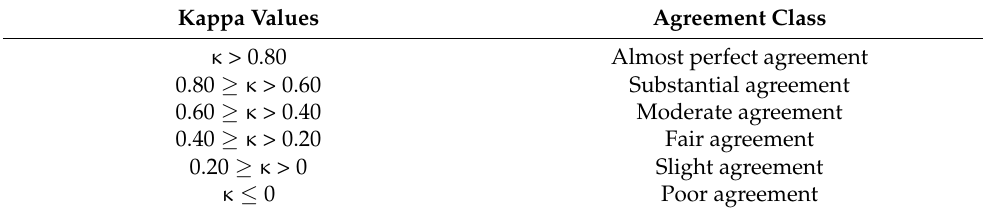
Table 3. Kappa values and interpretation